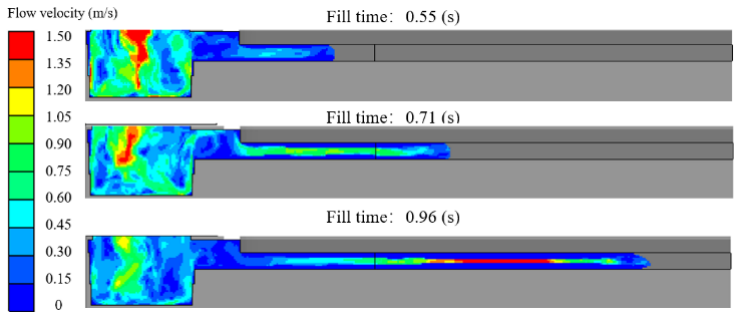
Figure 7. Cross-sectional diagram of simulation results.